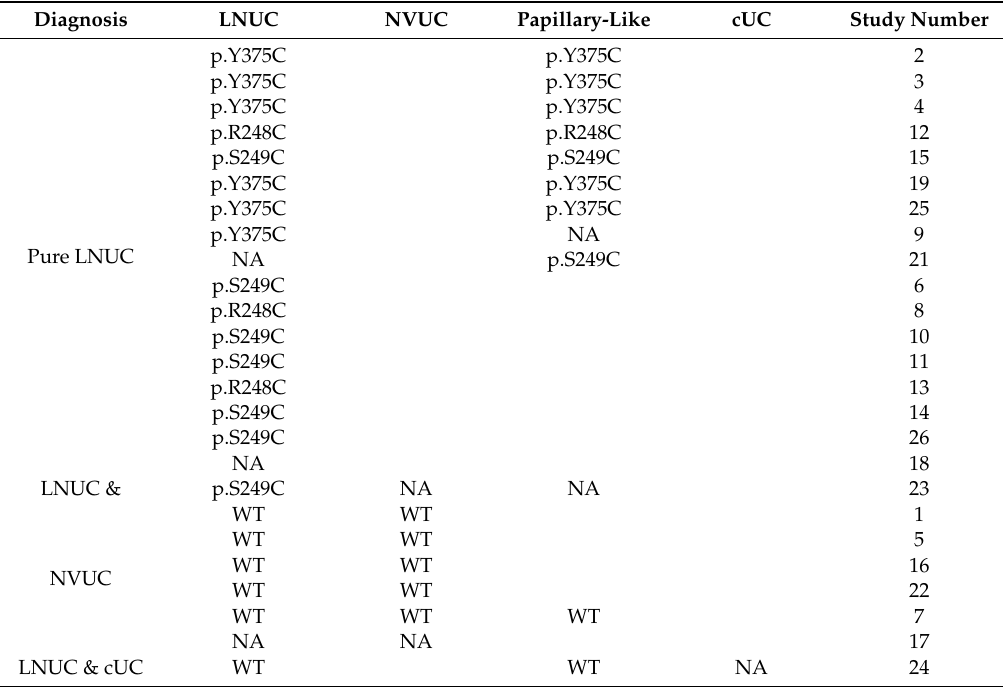
Table 2. FGFR 3 mutations in di ff erent components of LNUC